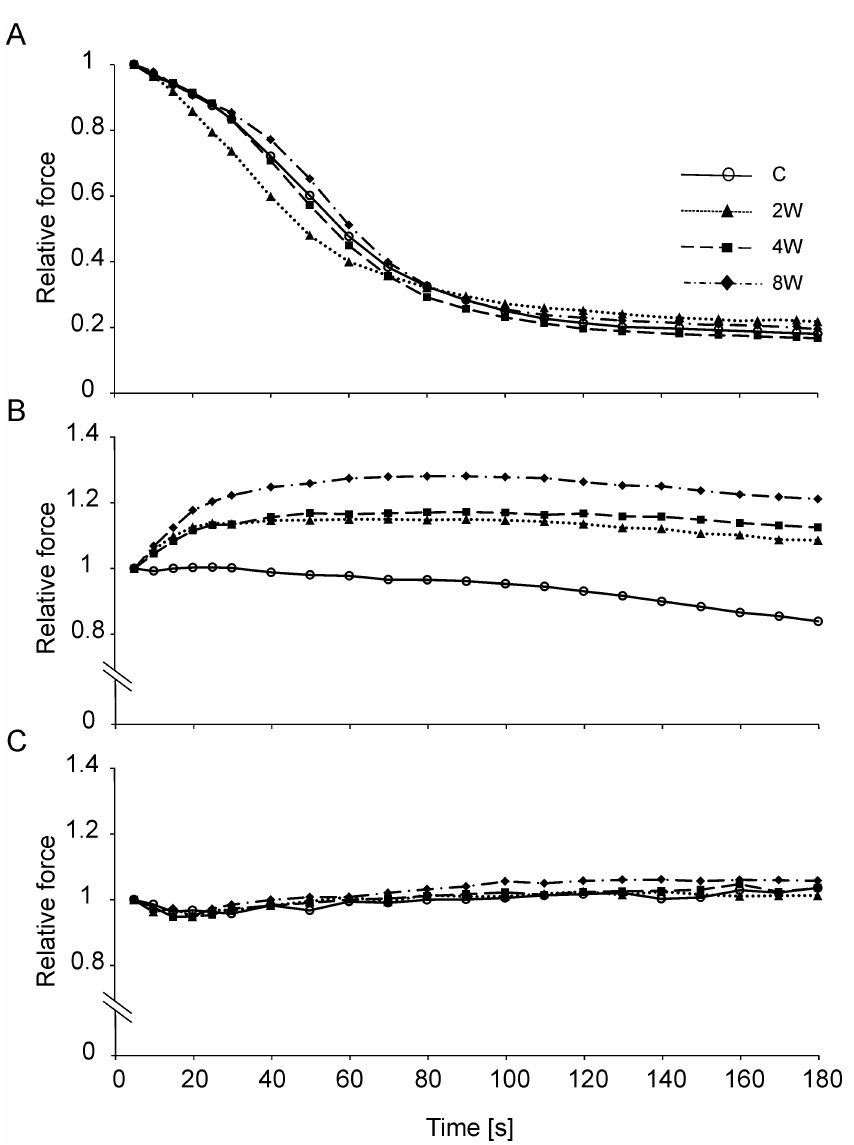
Fig 3. Force changes during the fatigue test for motor units in control and trained animal. The profiles of the fatigue test for fast fatigable (FF; panel A), fast fatigue-resistant (FR; panel B) and slow (S; panel C) motor units. The control (C) group is represented by open circles, the group trained for 2 weeks (2W) is represented by filled triangles, the group trained for 4 weeks (4W) is represented by filled squares, and the group trained for 8 weeks (8W) is represented by filled diamonds. The mean force over time for each group is presented as the relative values reached during the fifth second of the fatigue test, accepted as 1.0 (S5 File).